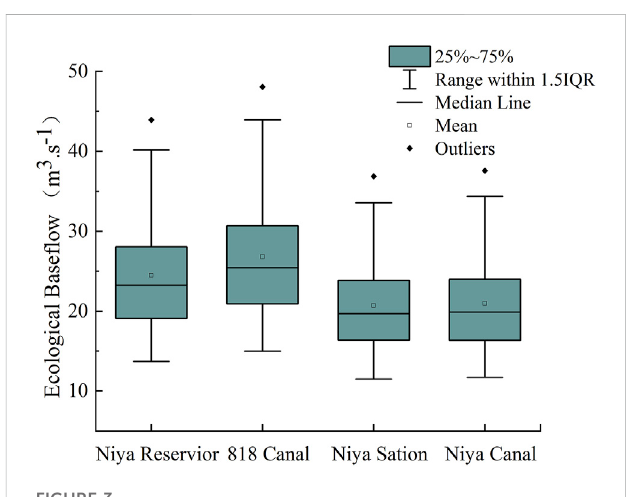
FIGURE 3 Distribution characteristics of the annual ecological base fl ows of the four